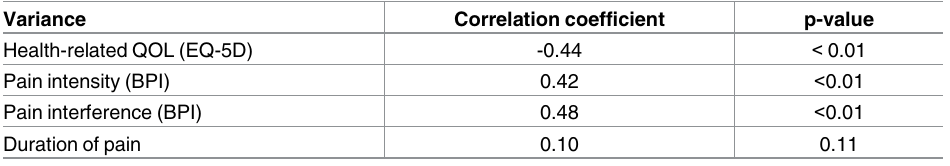
Table 2. Results of bivariate correlations between CSI-J and clinical